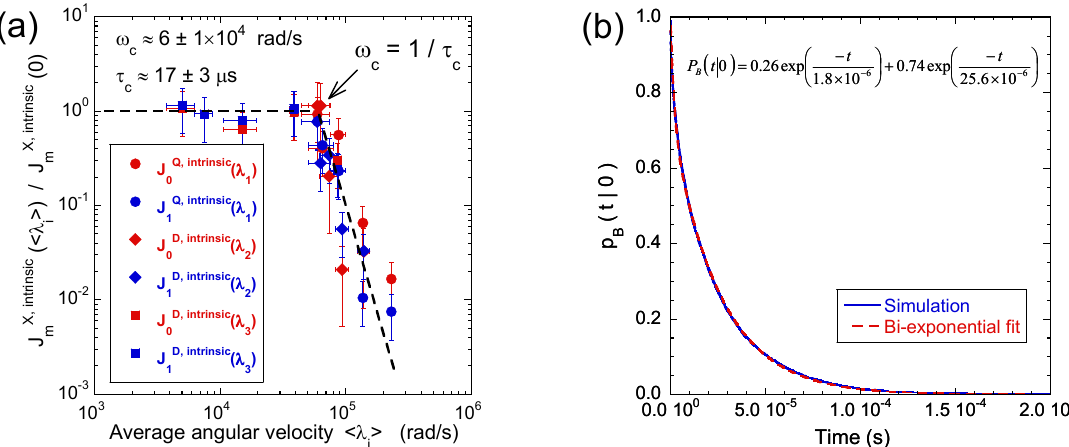
Figure 8. ( a ) Variation of the intrinsic spectral densities J Q , intr m ( λ 1 ) with m ∈ { 0,1 } , describing quadrupolar coupling, and J D , intr m ( λ i ) with m ∈ { 0,1 } and i ∈ { 2,3 } , describing the heteronuclear dipolar coupling, as a function of the corresponding averaged angular velocities < λ i > ( 2 H NMR); ( b ) average residence time of the confined water molecules obtained by numerical simulations of Brownian dynamics. Reprinted with permission from [51,53]. Copyright (2014 and 2012) American Chemical